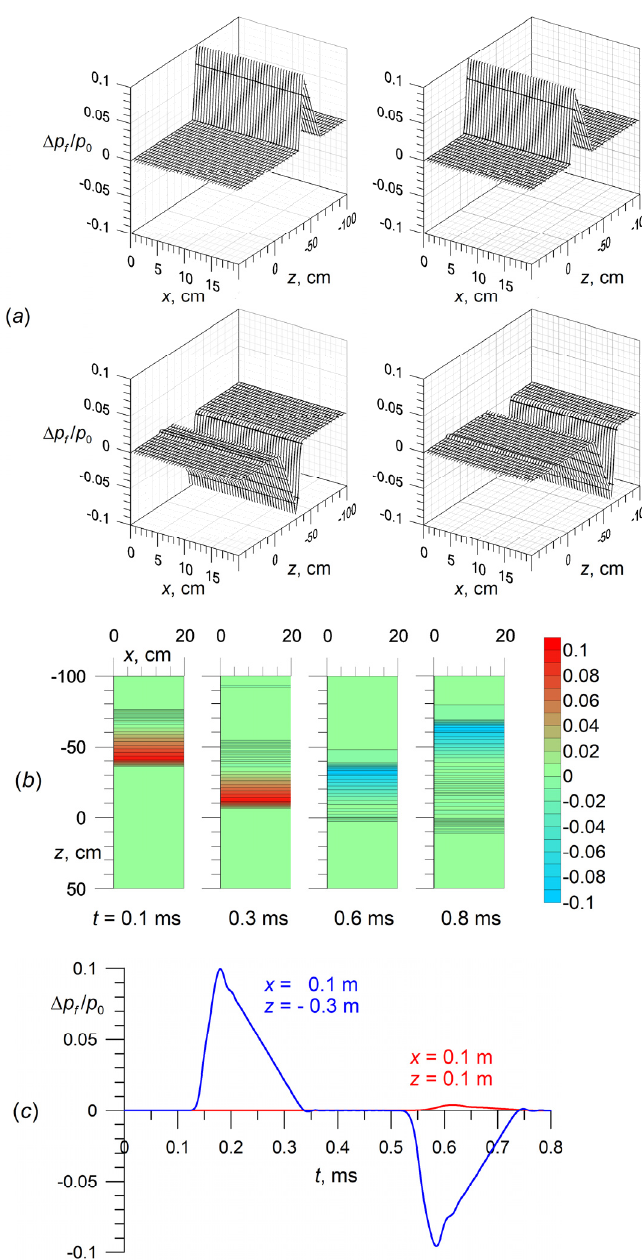
Figure 2. The passage of a traveling plane wave through the boundary of two single-phase media. The profiles ( a ) and fields ( b ) of the dimensionless pressure difference ∆ p f / p 0 when a traveling plane wave passes through the boundary of two single-phase media for several time points. The color scale on the right ( b ) shows the pressure level ∆ p f / p 0 . Calculated “oscillograms” of pressure at two points for the first (blue line) and second (red line) media ( c ).